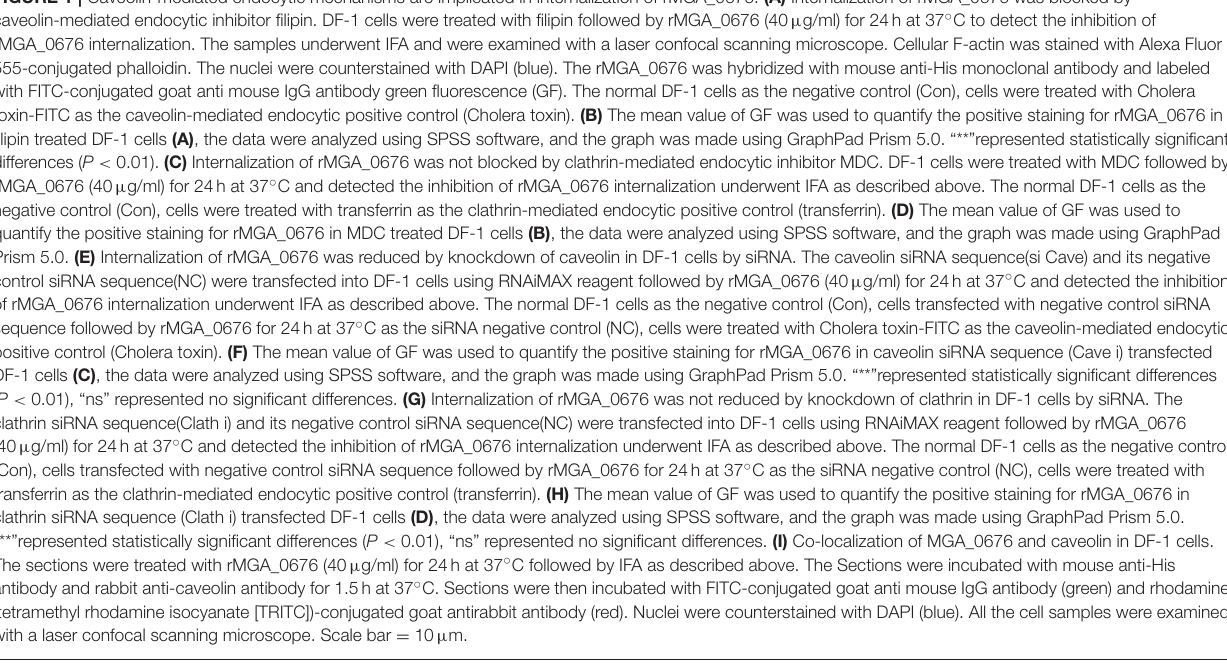
Frontiers in Cellular and Infection Microbiology |